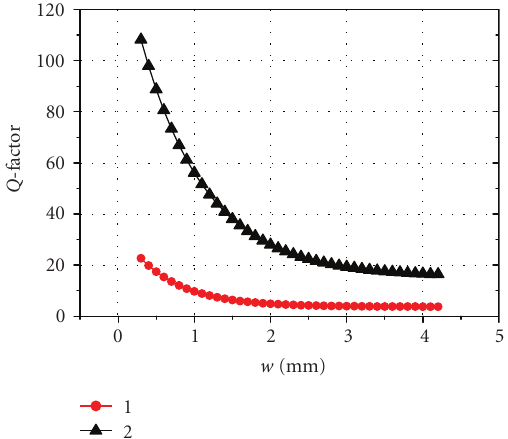
Figure 5: The dependence of the resonance frequency on the slot depth: (1) a = 9mm, b = 15 mm, w = 0 . 5 mm, ε 1 = ε 2 = 1; (2) a = d , b = 15 mm, w = 0 . 5mm, ε 1 = 1, ε 2 = 3 . 78.